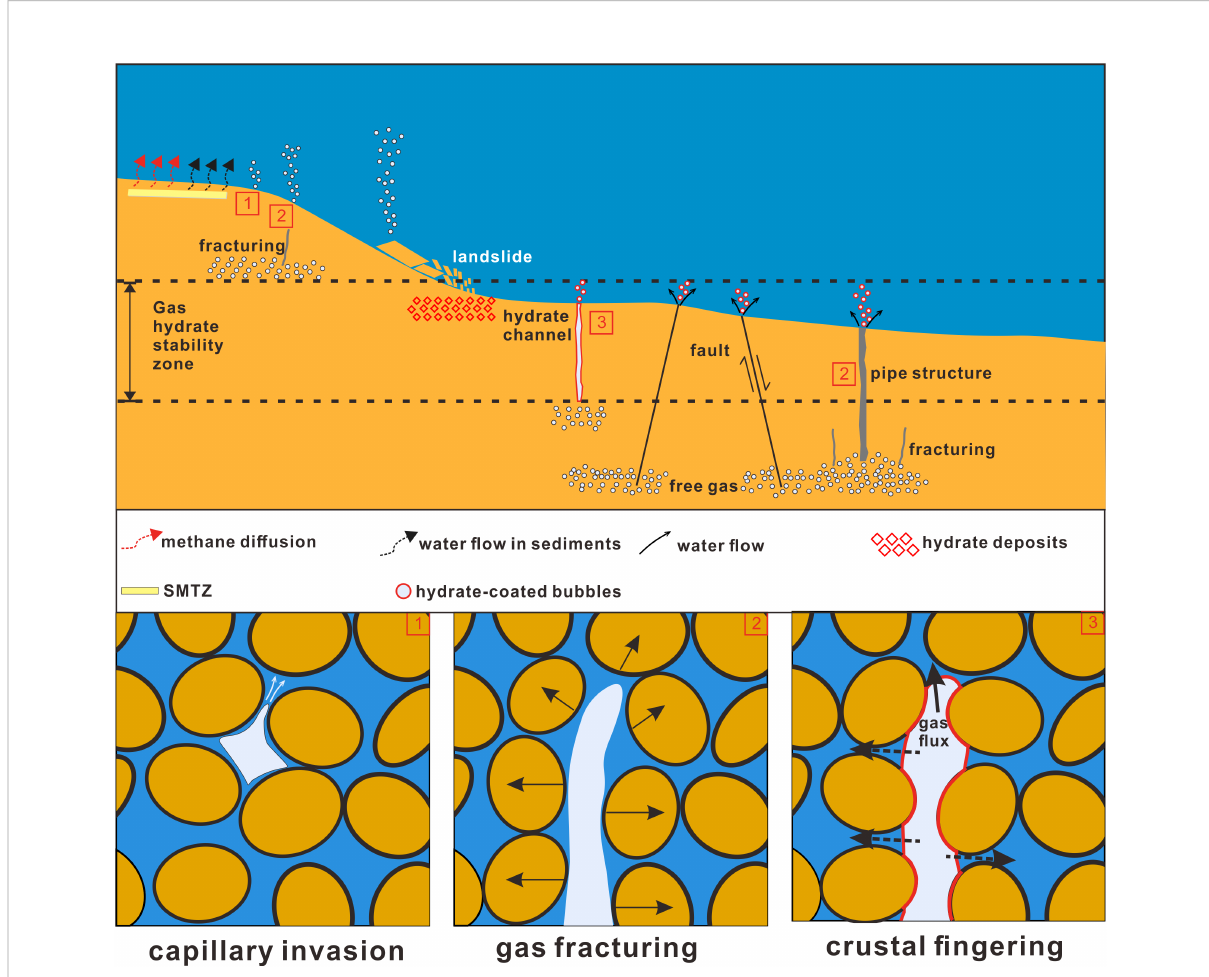
FIGURE 7 A comprehensive illustration of various mechanisms for methane migration [modi fi ed from Ma et al.